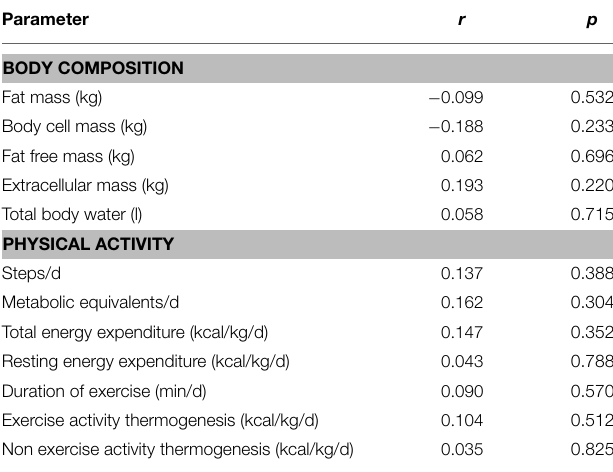
TABLE 4 | Correlation of plasma bile acids with physical activity in a population of anorexic patients with broad activity